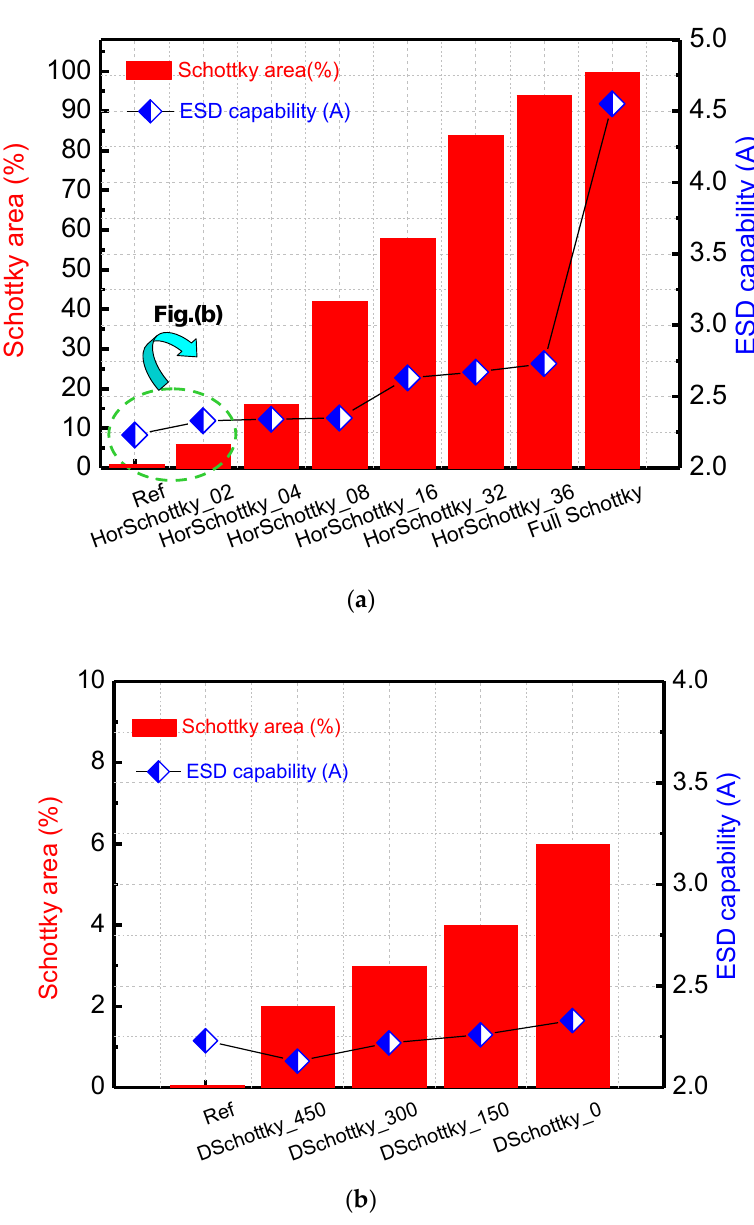
Figure 11. ESD capability (I t2 ) values and Schottky-area % comparison of HV nLDMOSs with the drain electrode-embedded horizontal Schottky elements by the ( a ) row modulation and ( b ) length modulation.